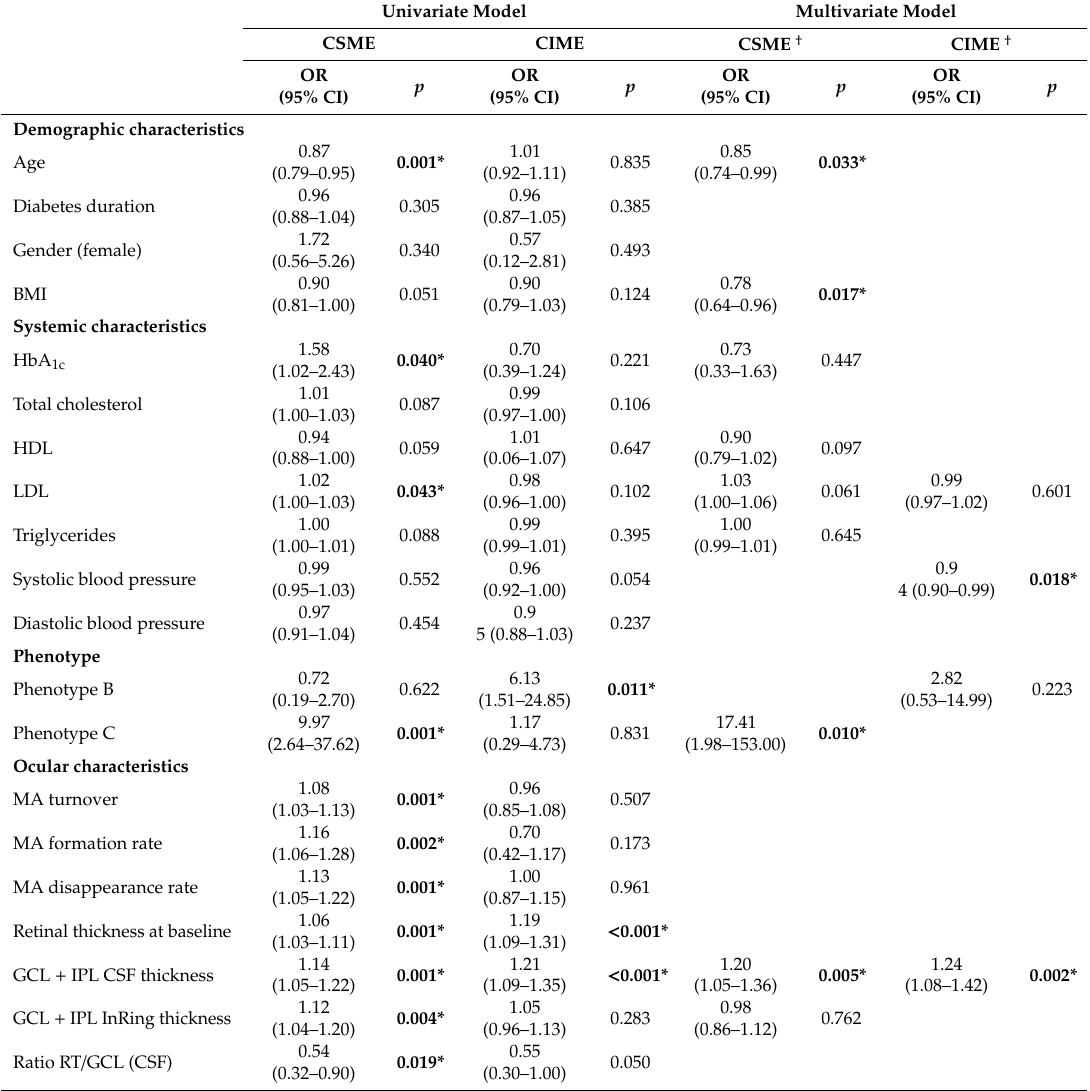
Table 4. Univariate and multivariate analyses of OR for CSME and CIME on a logistic